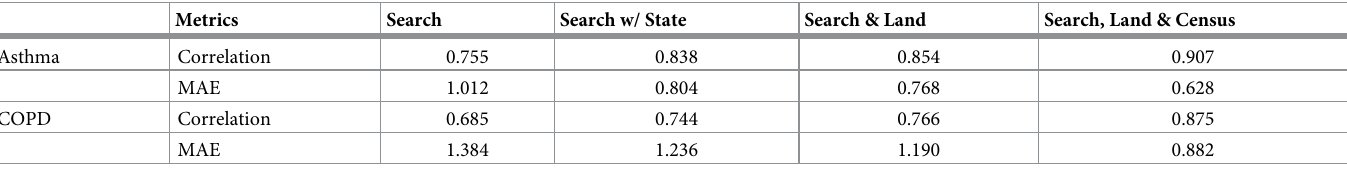
Table 2. Correlation and MAE values for models trained using different data sources. Metrics Search Search w/ State Search & Land Search, Land & Census